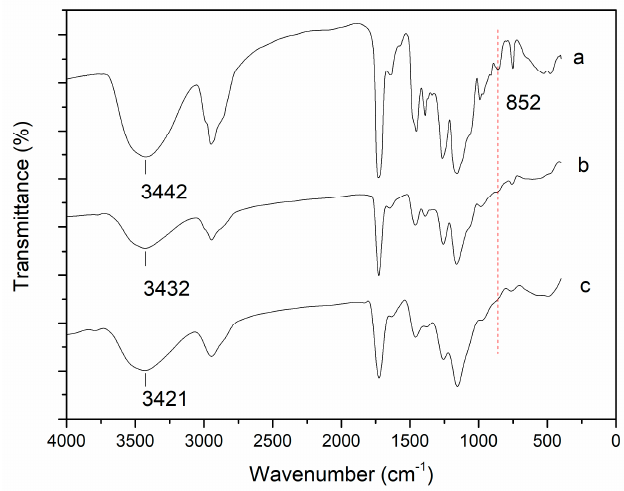
Figure 4. FT-IR spectra of the ( a ) native HFA, ( b ) unblocked DPEase, and ( c ) blocked DPEase.